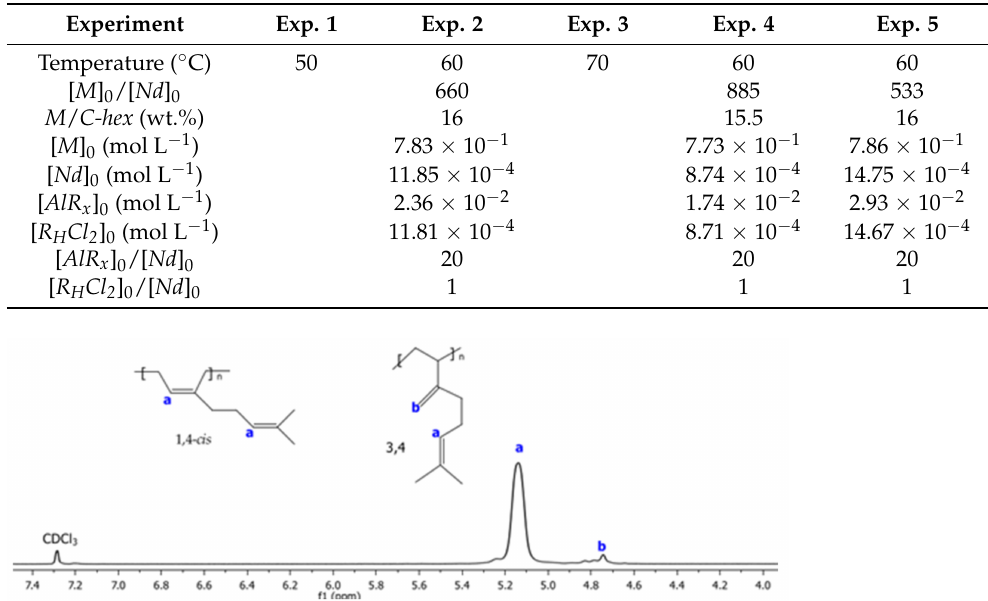
Figure 2. 1 H NMR spectra using CDCl3 as solvent of poly( β -myrcene) for Exp. 2.